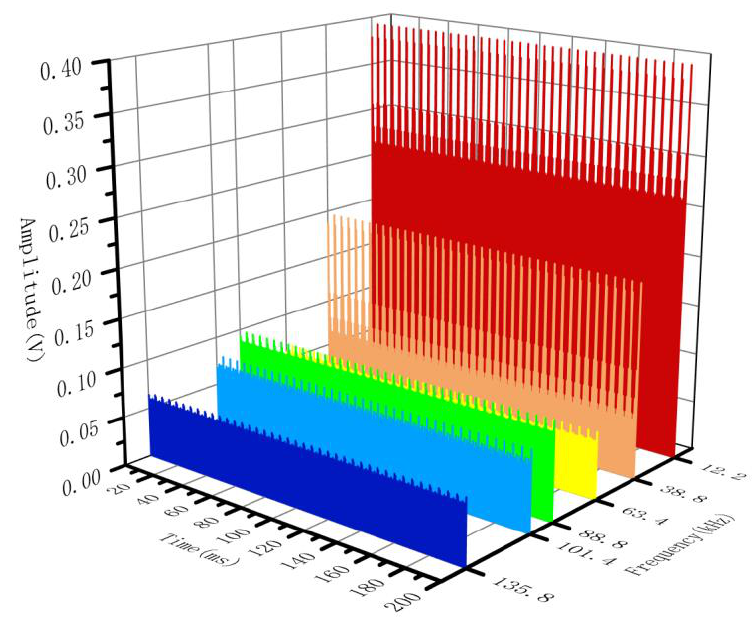
Figure 4. Class D test signal simulation results.